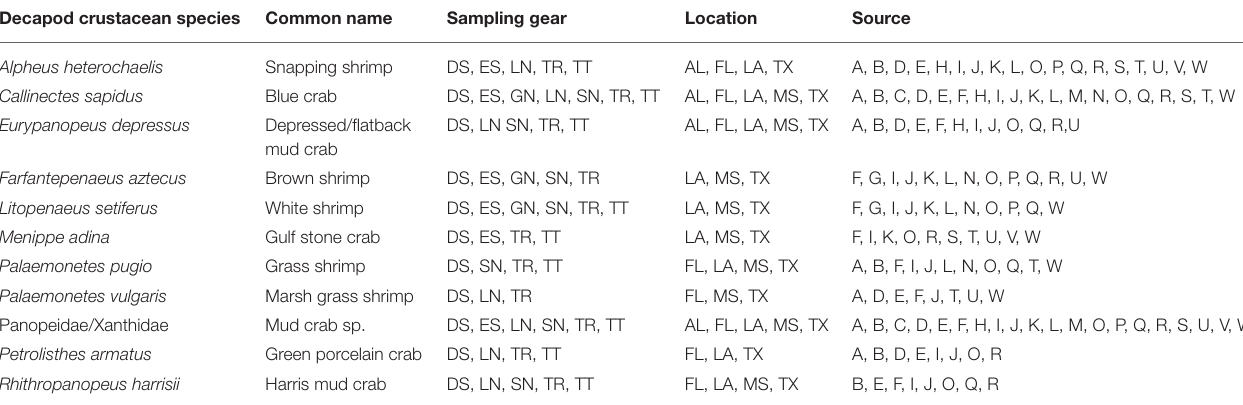
TABLE 4 | List of decapod crustacean species reported in 8 studies or more, with sampling gear, location, and